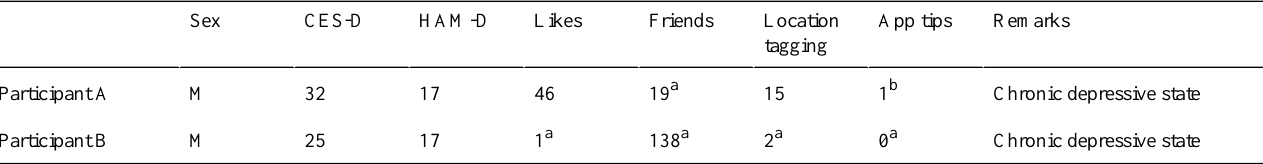
Table 5. Characteristics of